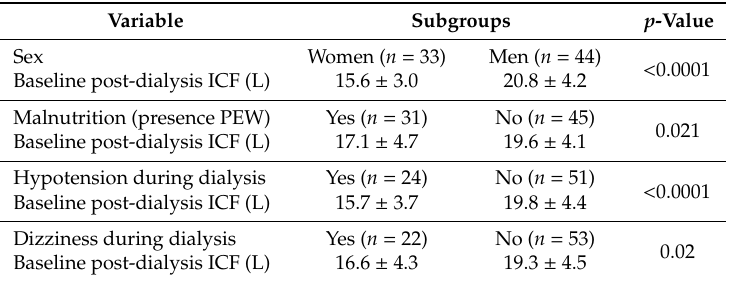
Table 3. Baseline post-dialysis ICF (L) in subgroups of patients.